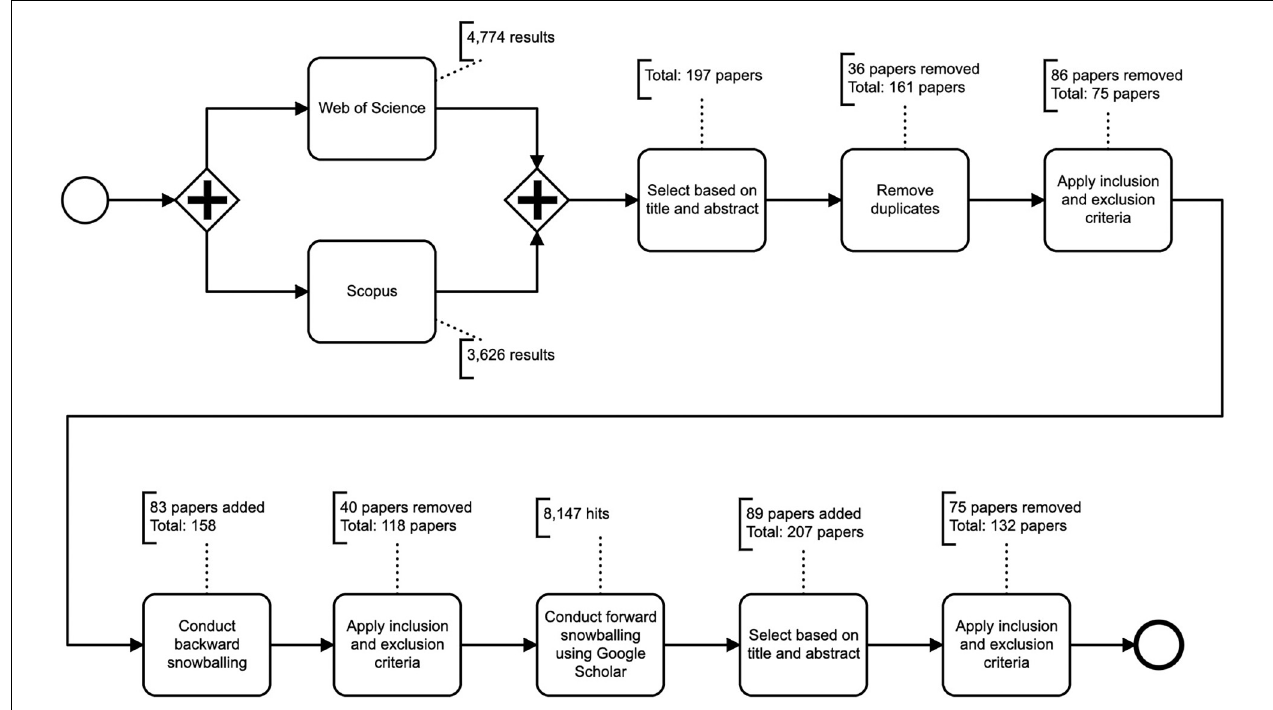
FIGURE 1 | Overview of the search